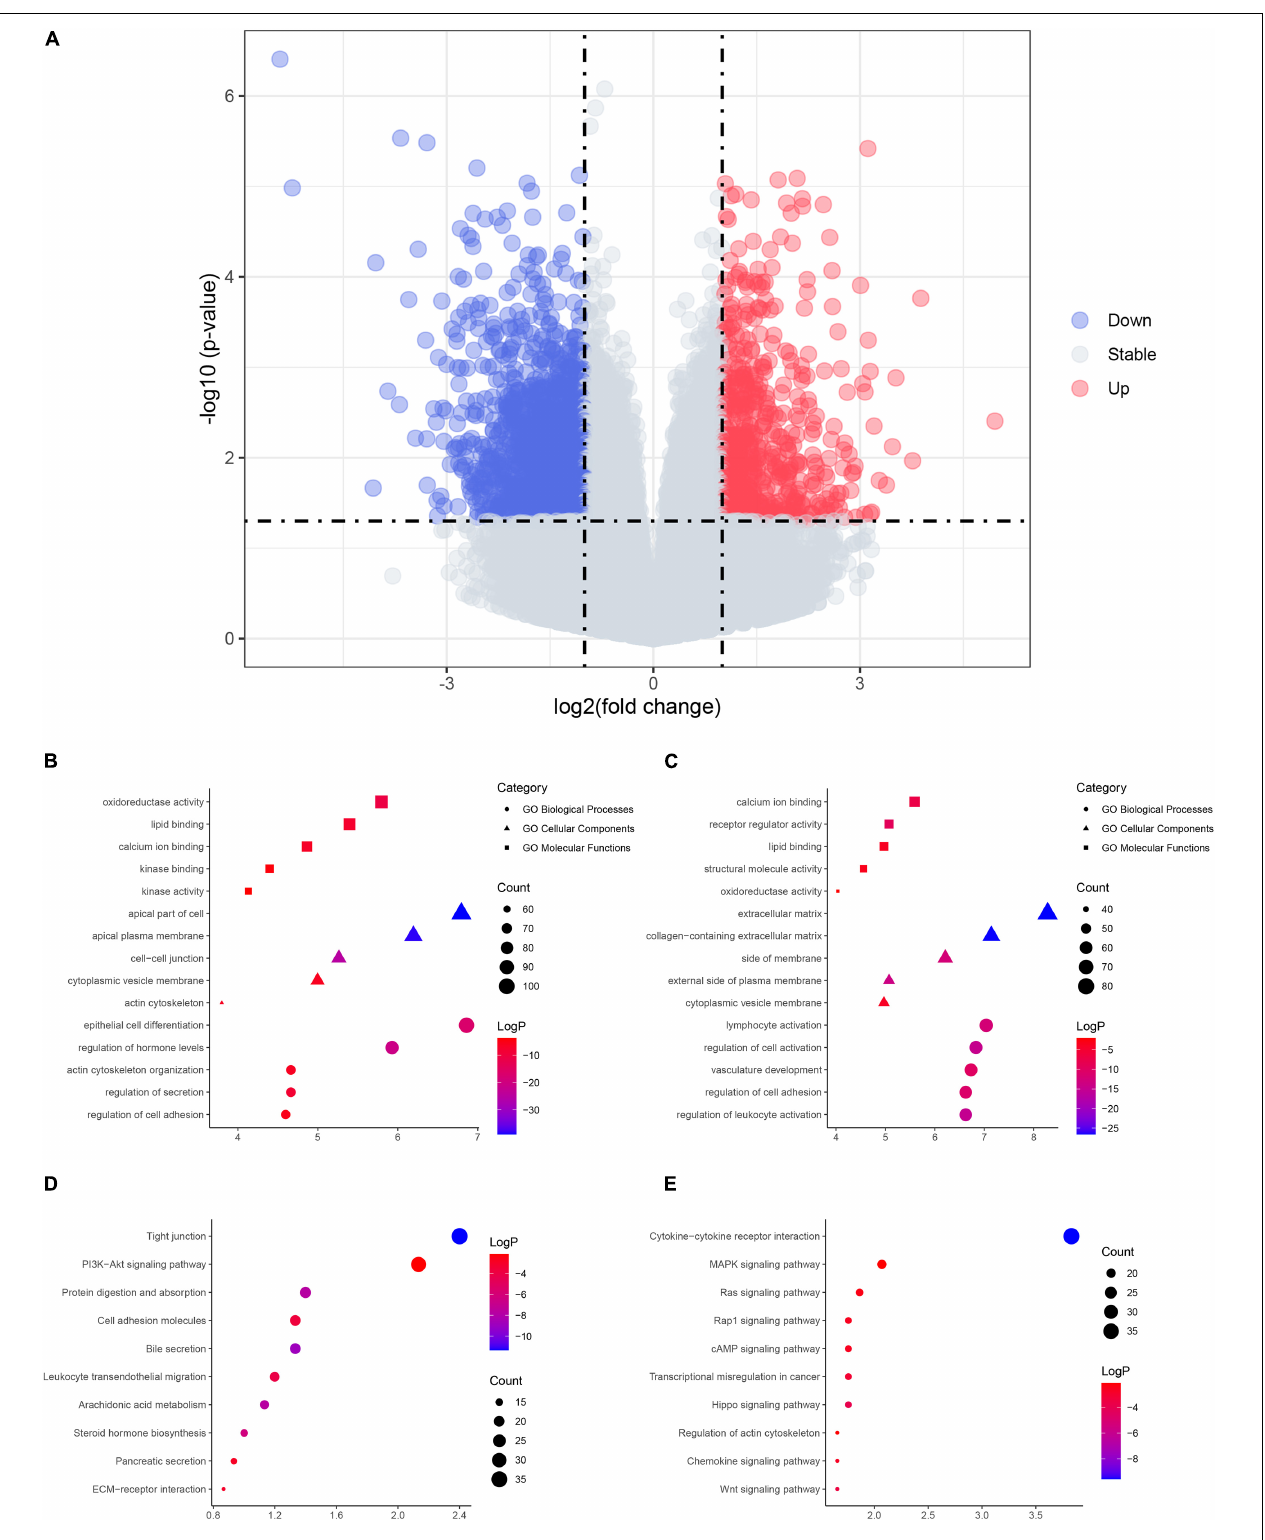
FIGURE 1 | The volcano plot and enrichment analysis of differentially expressed genes (DEGs). (A) Volcano plot of DEGs. Red, upregulated genes in cystic choledochal cysts (CCs); blue, downregulated genes in cystic CCs. (B) The enriched Gene Ontology (GO) terms of upregulated DEGs. (C) The enriched GO terms of downregulated DEGs. (D) The enriched pathways of upregulated DEGs. (E) The enriched pathways of downregulated DEGs.